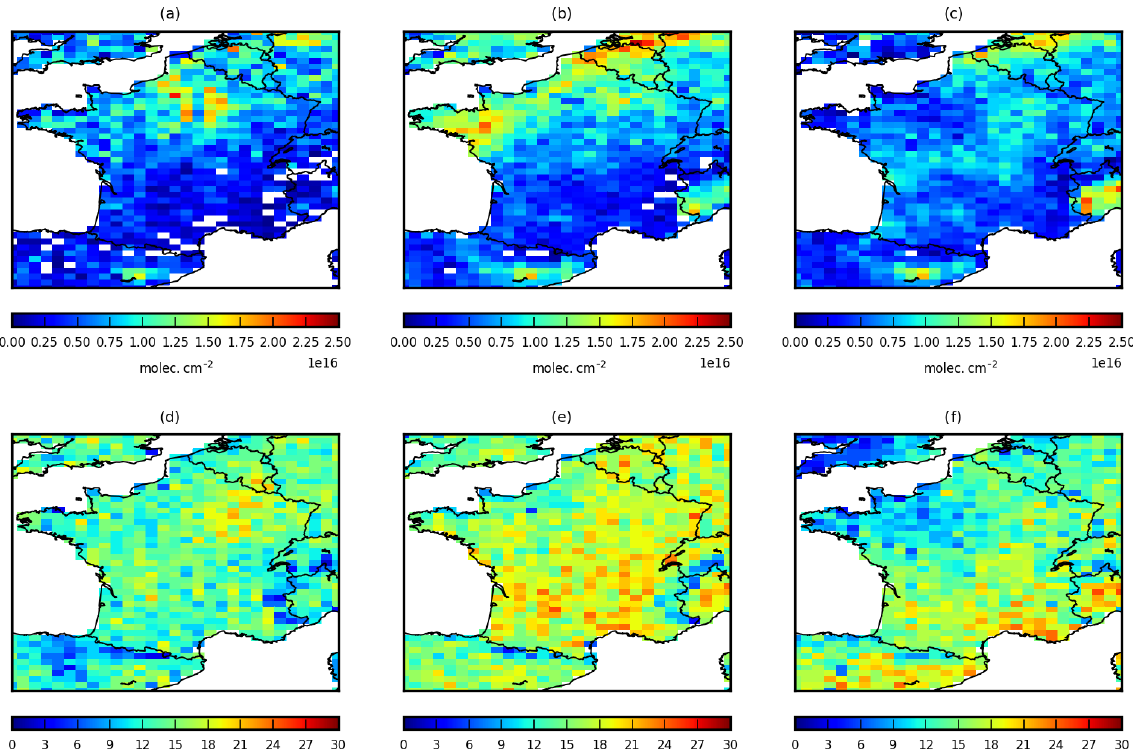
Figure 1. (a–c) Monthly means of IASI “super-observations” for (a) March 2011, (b) April 2011 and (c) May 2011. Units are molecules per square centimeter (molec . cm − 2 ). (d–f) Total number of IASI super-observations per month in (d) March 2011, (e) April 2011 and (f) May